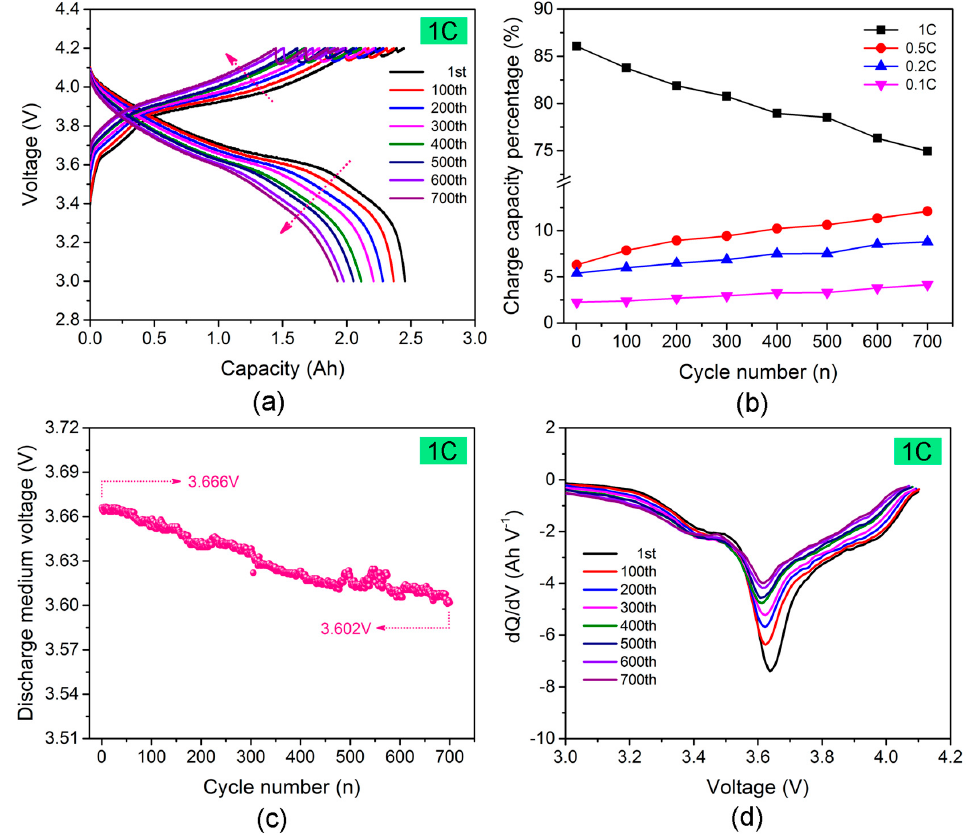
Figure 2. ( a ) Charge/discharge profiles at 1 C rate; ( b ) Charge capacity percentage at 1 C, 0.5 C, 0.2 C and 0.1 C rate based on the total charge capacity with cycling; ( c ) Discharge medium voltage at 1 C rate; ( d ) Discharge dQ/dV plots at 1 C rate of the LCO+NCM532/Gr full cells.